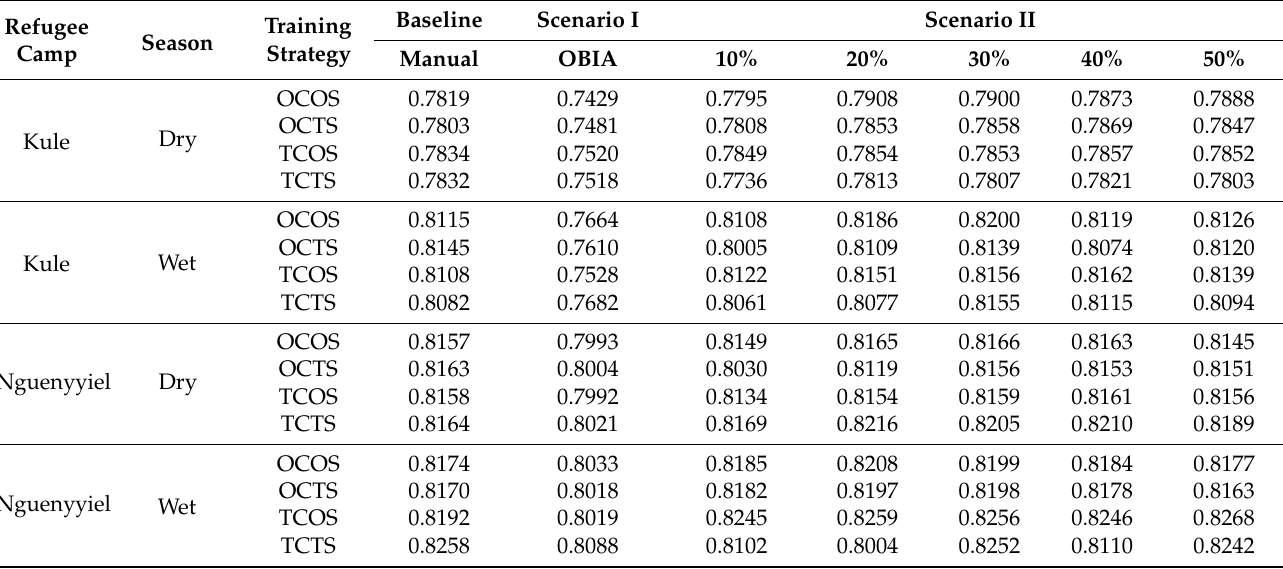
Table A2. The mean IoU values of built-up structures of all implemented